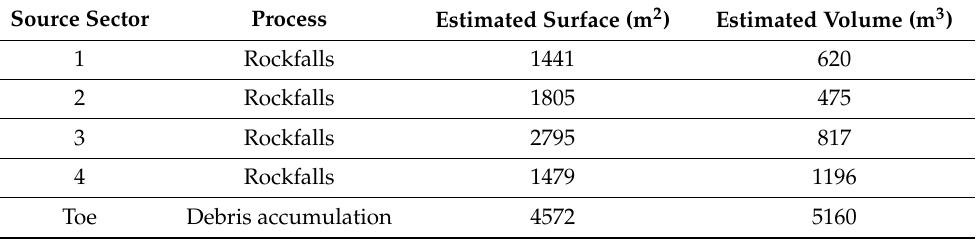
Figure 5. Analysis of three-dimensional differences between the 2016 and 2019 SfM point clouds. White contour lines indicate sectors from which the largest volumes of rock have detached. The colour bar is saturated at ±8 m, and the detection threshold is set to ±0.3 m. Table 1. Surface and volume estimation related to rockfall processes that occurred between April 2016 and May 2019 at the Poggio Baldi rock scarp.